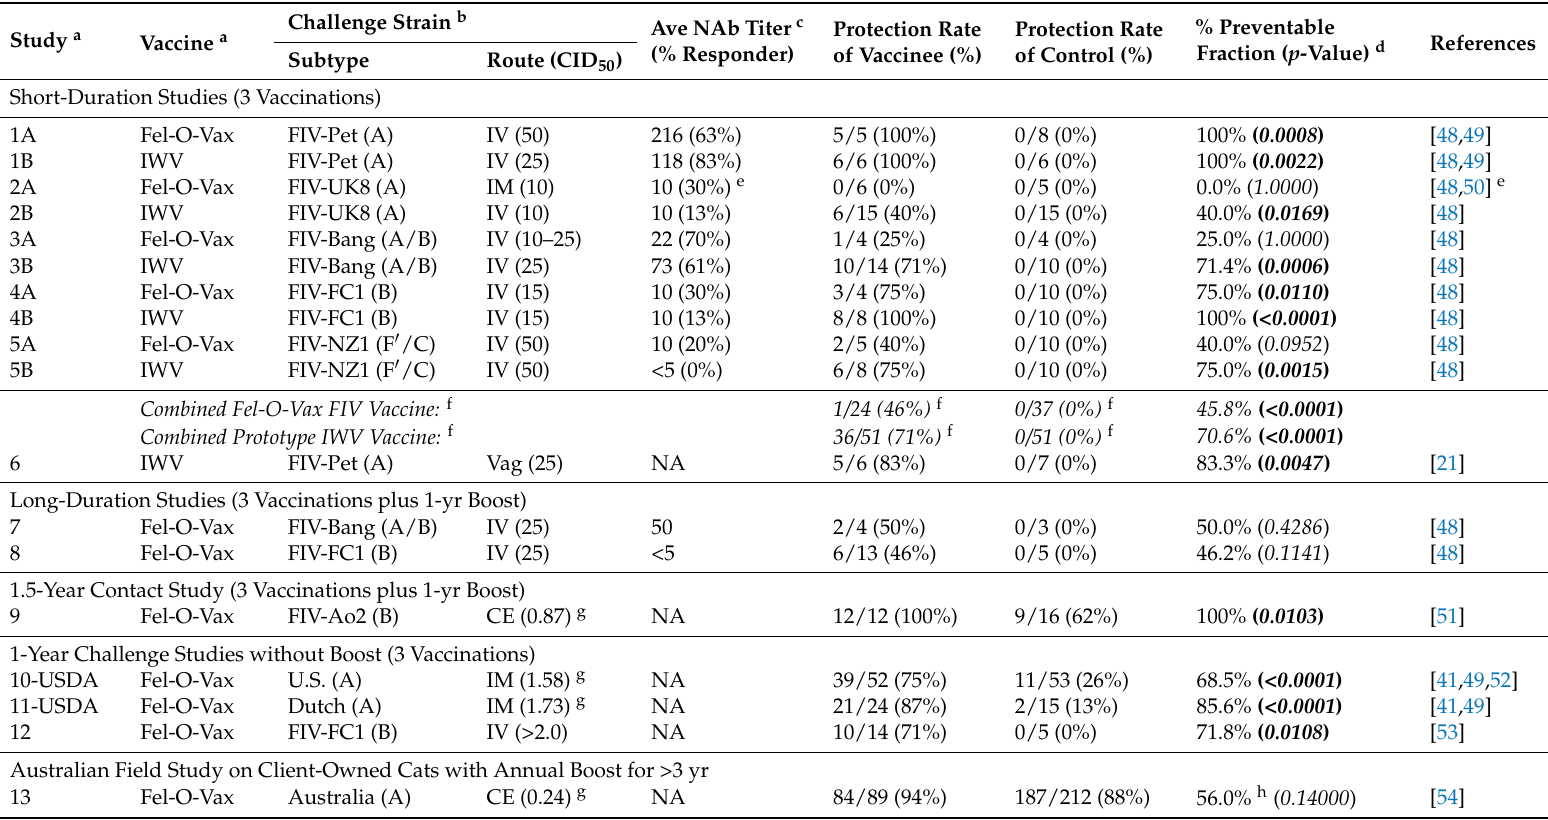
Protection Rate References